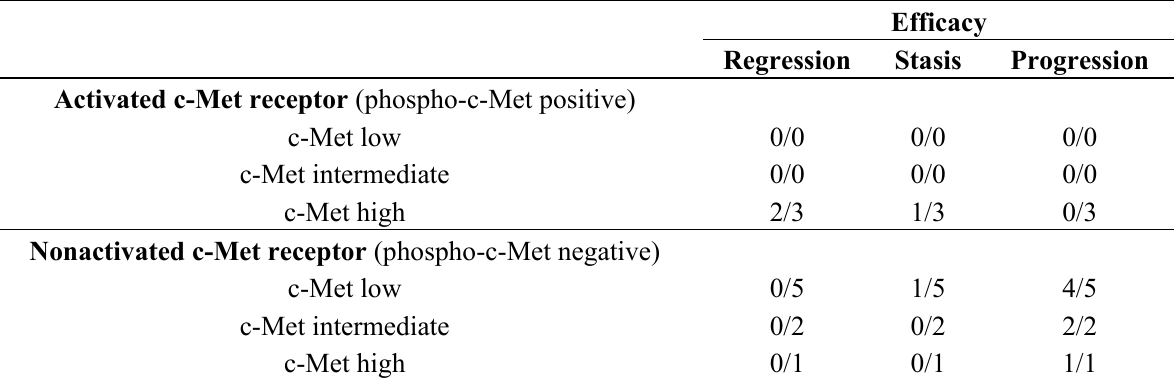
Table 1. Efficacy of MSC2156119J and c-Met activation status in patient-derived HCC xenograft models with low (IHC score = 0–1), intermediate (IHC score = 2), and high (IHC score = 3) c-Met